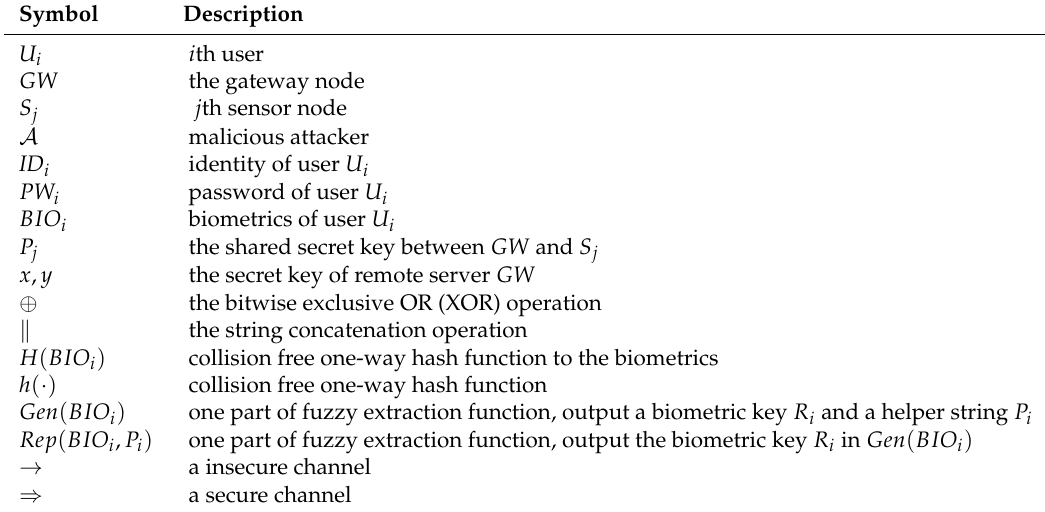
Table 1. Notations and